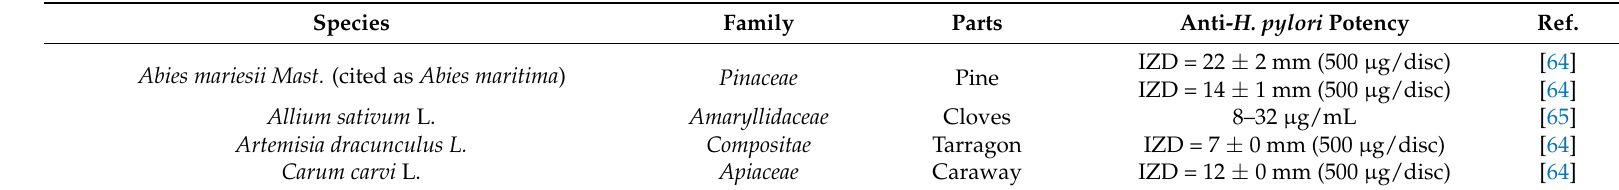
Table 2. Plant essential oils with anti- H. pylori